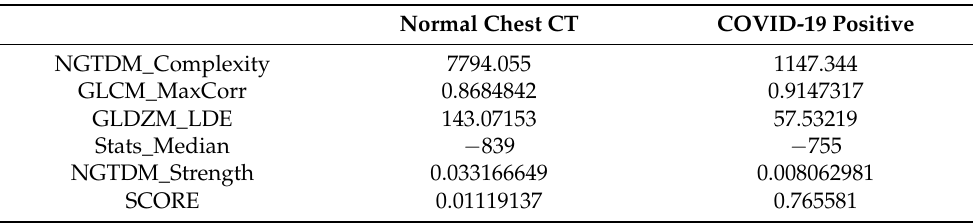
Table 3. Top 5 radiomics features and model scores of cases depicted in Figure